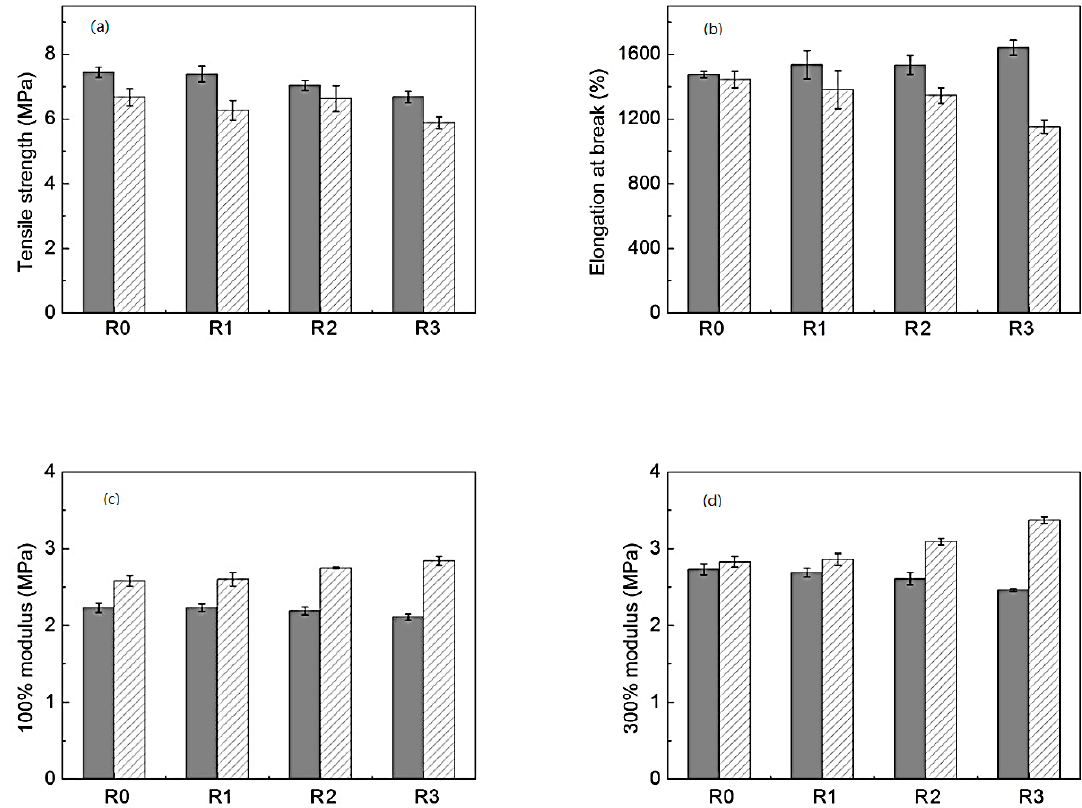
Figure 8. Properties of the pure thermoplastic elastomers (TPEs) (dark) and TPE-based MREs (stripped) subjected to various processing cycles (R0–R3) ( a ) Tensile strength, ( b ) Elongation at break, ( c ) 100% Modulus, ( d ) 300% Modulus [30] (reprinted with permission from Elsevier TM ).